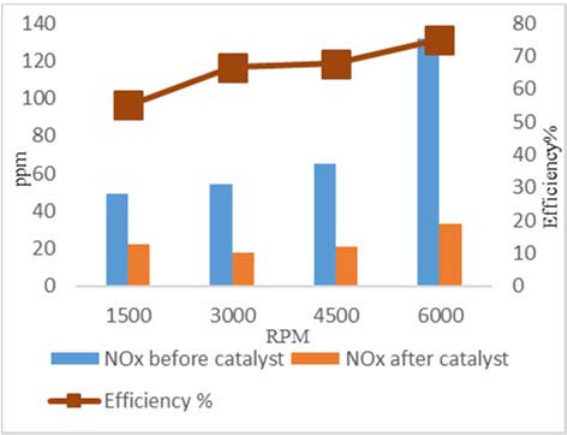
Figure 7. Conversion of NO X with 8 wt.% ZrO 2 ‐ Co 3 O 4 /TiO 2 .